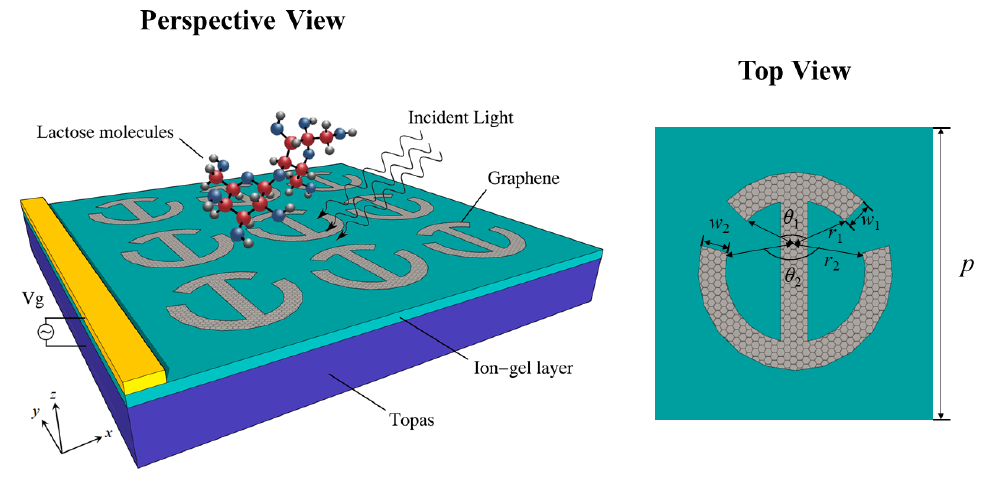
Figure 1. Schematic diagram of sensor based on arc I-graphene structure